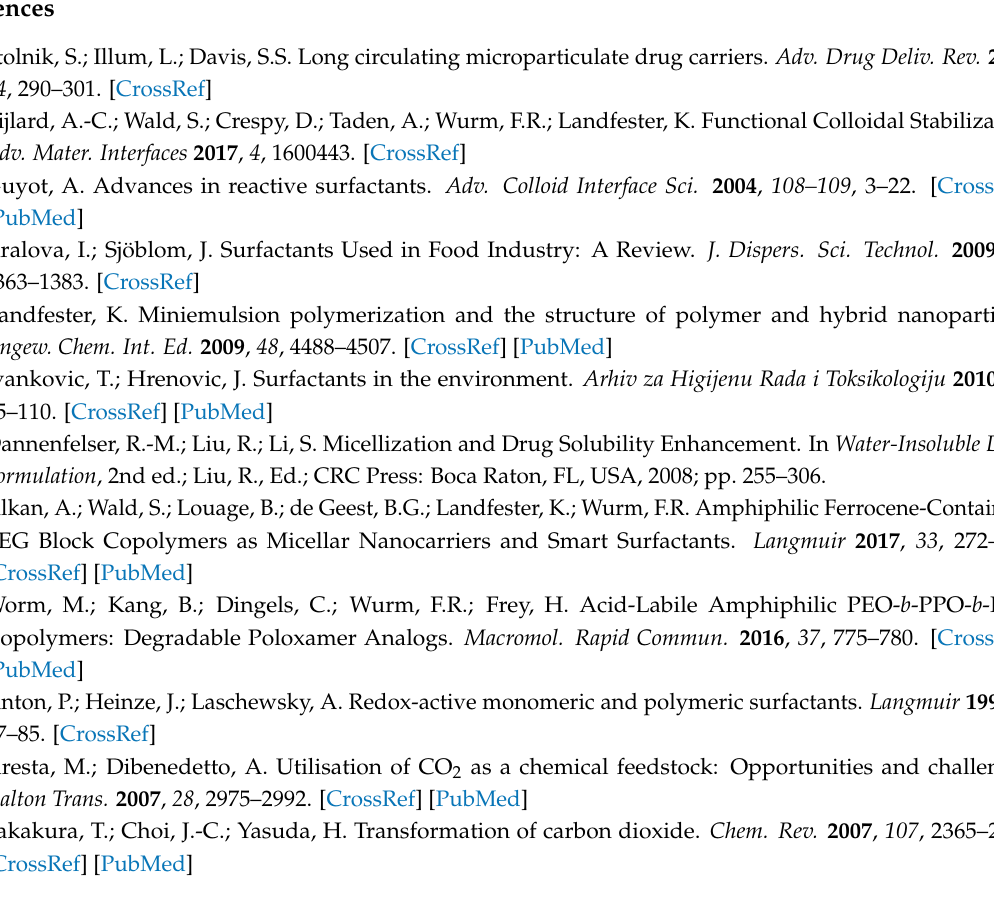
(Table 1, sample 4–8) in comparison with the mPEG 45 initiator using DMF as an eluent and PEG calibration, Figure S5: SEC traces of all PPC- b -PEG 45 - b -PPC ABA-triblock copolymer surfactants (Table 1, sample 9,10) in comparison with the PEG 45 initiator using DMF as an eluent and PEG calibration, Figure S6: Surface tension measurements of an aqueous solution of mPEG 113 - b -PPC 49 (Table 1, sample 3) for the determination of the CMC, Figure S7: Degradation reaction of mPEG 113 - b -PPC 49 (Table 1, sample 3) in aqueous hydrochloric solution (pH 1) after 8 days and 26 days at RT, 50 ◦ C and 70 ◦ C, respectively, Figure S8: Online 1 H NMR degradation study of mPEG 113 - b -PPC 49 (Table 1, sample 3) in hydrochloric aqueous solution (pD 1). Comparison of all degradation products in units per mPEG 113 at different reaction temperatures (RT, 50 ◦ C, 70 ◦ C), Figure S9: SEC traces of the degradation study of mPEG 113 - b -PPC 49 (Table 1, sample 3) in hydrochloric aqueous solution (pH 1) at room temperature in comparison with the mPEG 113 initiator using DMF as an eluent and PEG calibration, Figure S10: SEC traces of the degradation study of mPEG 113 - b -PPC 49 (Table 1, sample 3) in hydrochloric aqueous solution (pH 1) at 50 ◦ C in comparison with the mPEG 113 initiator using DMF as an eluent and PEG calibration, Figure S11: SEC traces of the degradation study of mPEG 113 - b -PPC 49 (Table 1, sample 3) in hydrochloric aqueous solution (pH 1) at 70 ◦ C in comparison with the mPEG 113 initiator using DMF as an eluent and PEG calibration, Figure S12: SEM image of the synthesized PS nanoparticles (NP2, NP4 and NP6). Scale bar = 1 µ m, Figure S13: Picture of a stable aqueous nanoparticle dispersion with LutAT50 as a surfactant before (left) and after (right) the treatment with conc. HCl solution (36